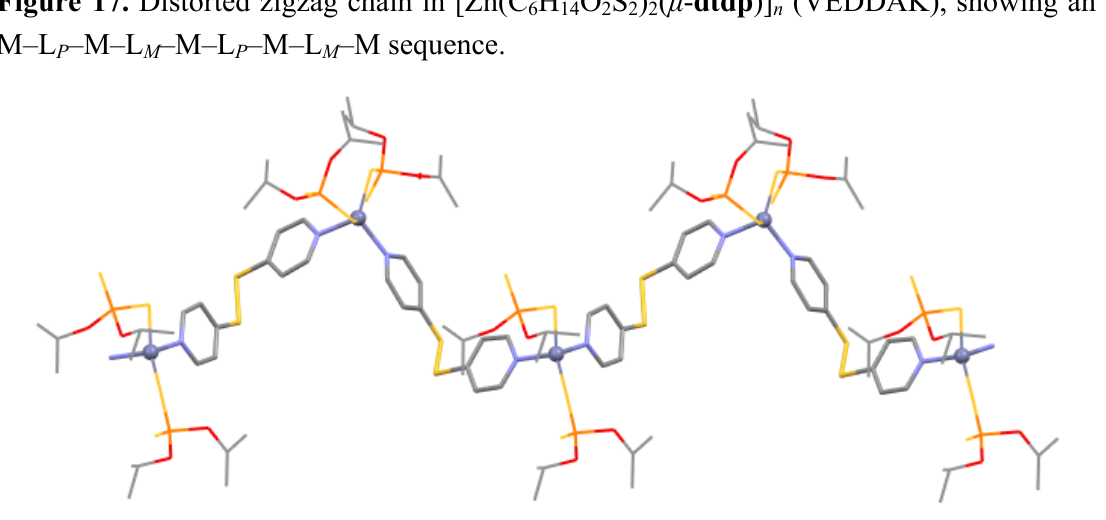
Figure 17. Distorted zigzag chain in [Zn(C